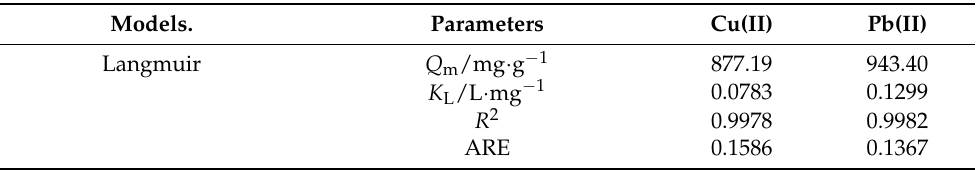
Figure 11. Langmuir ( a ), Freundlich ( b ), Dubinin – Radushkevich ( c ), Temkin ( d ), and Redlich – Peterson ( e ) adsorption isotherms for the adsorption of Cu( Ⅱ ) ( a ) or Pb( Ⅱ ) ( b ) on MOMMC. Table 5. Adsorption isotherm parameters and error analysis for the adsorption of Cu( Ⅱ ) or Pb( Ⅱ ) on MOMMC.